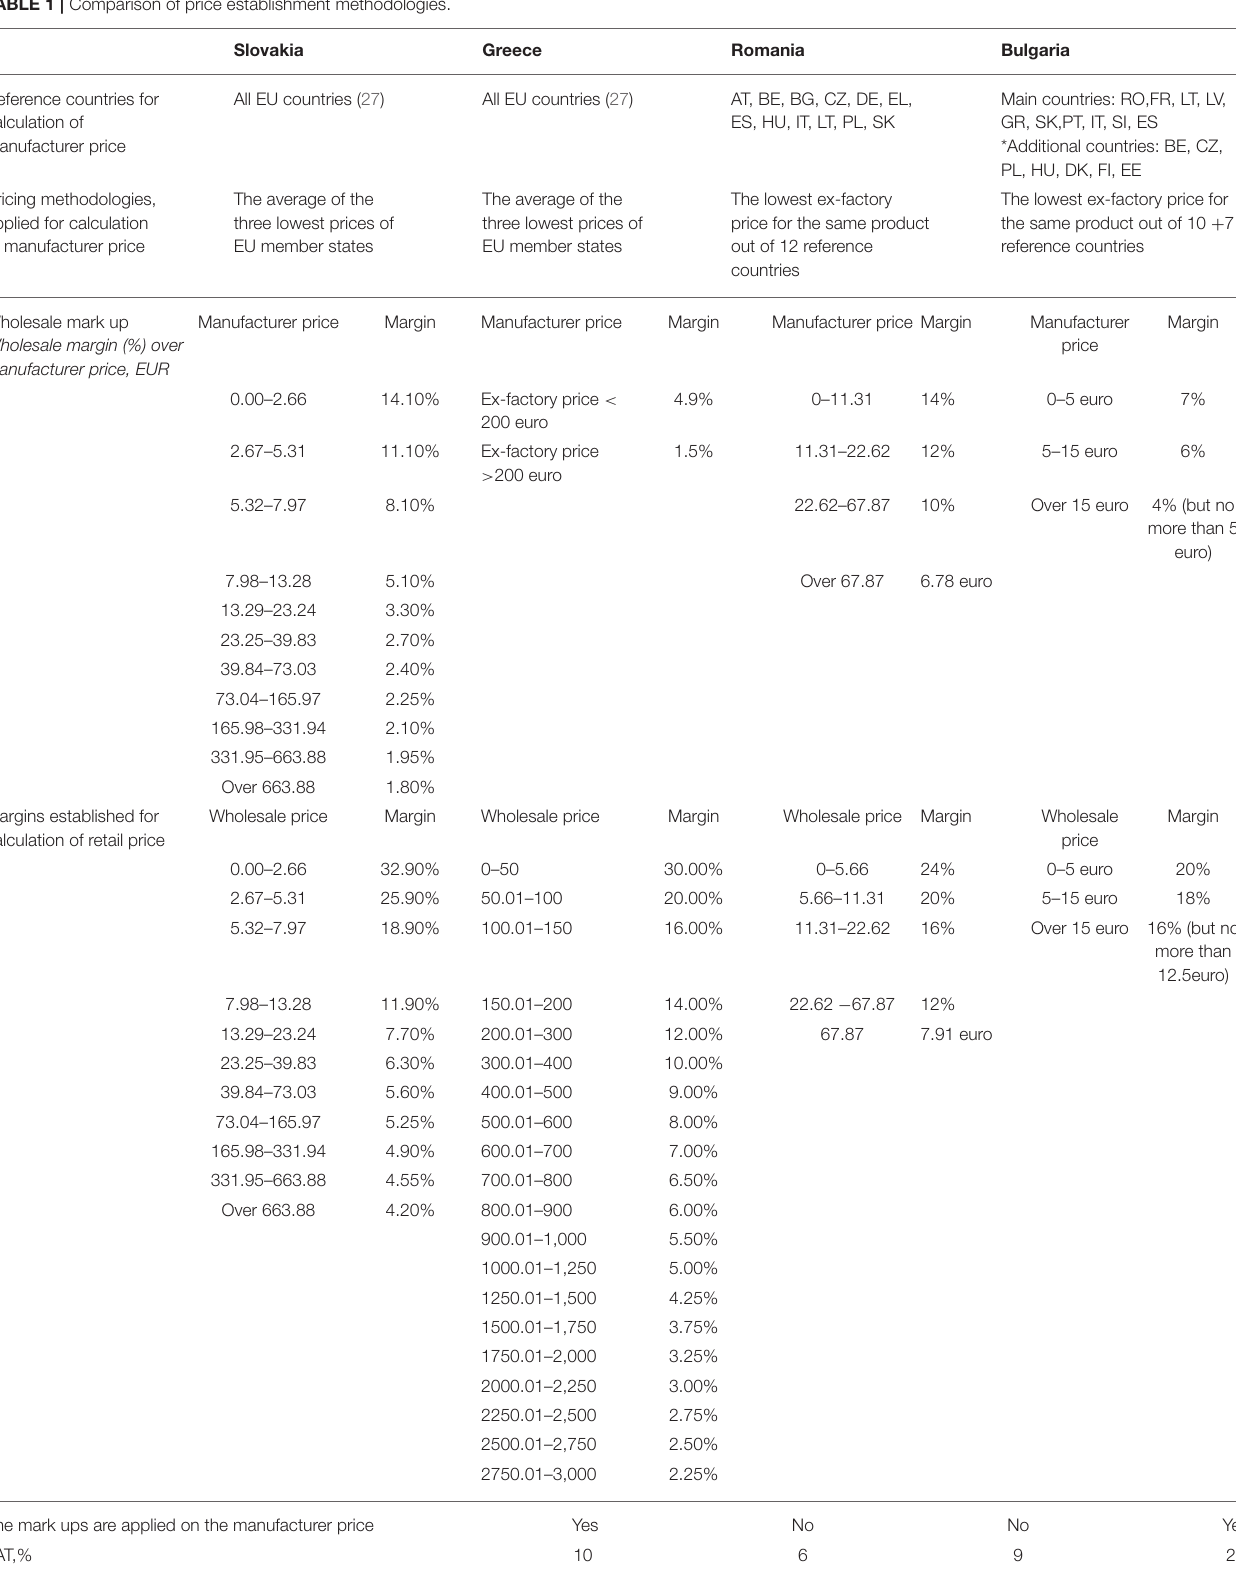
TABLE 1 | Comparison of price establishment